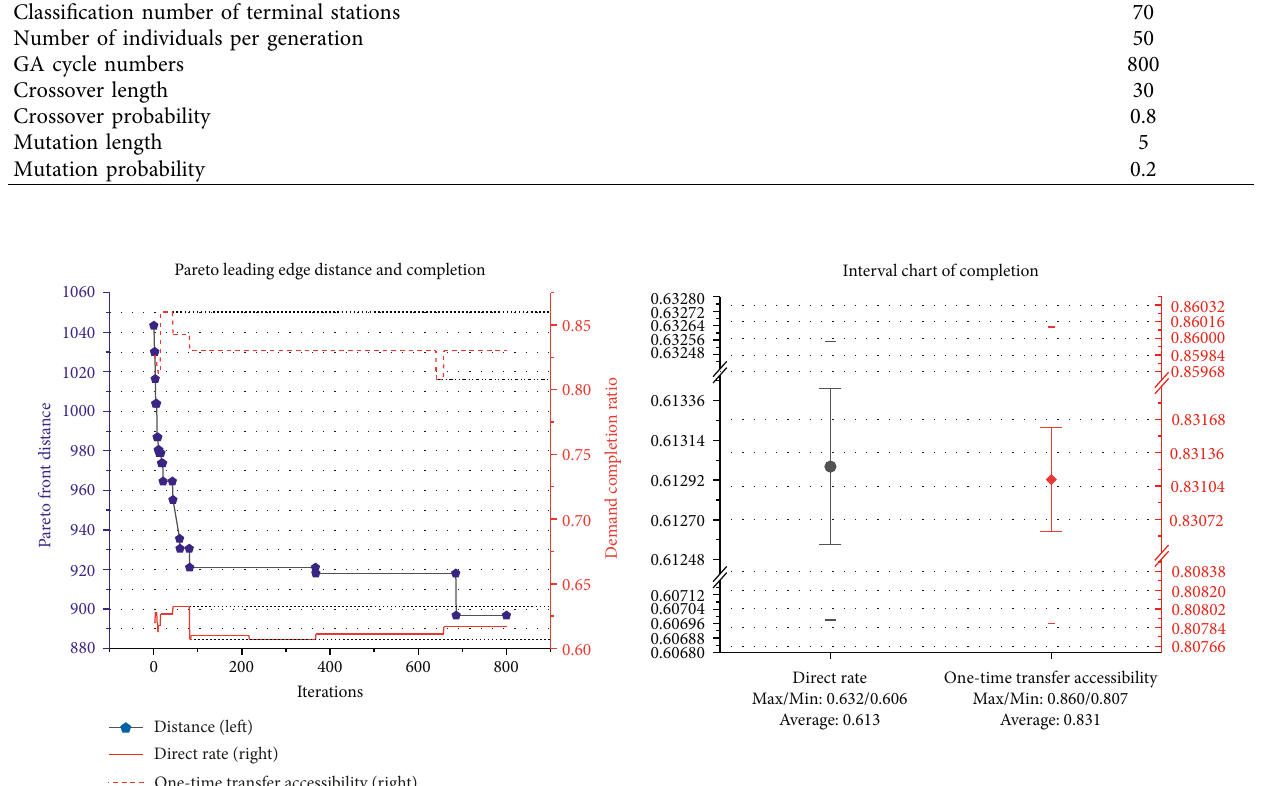
Figure 11: Achievable efficiency and index optimization.